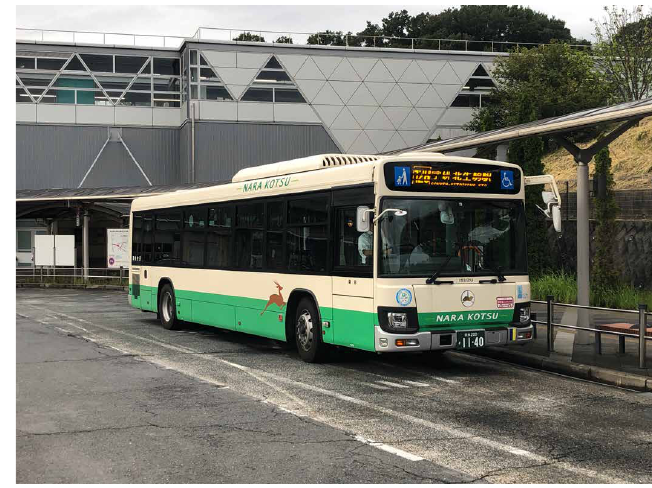
Figure 4. The actual bus in cooperation with Nara Kotsu Co., Ltd.